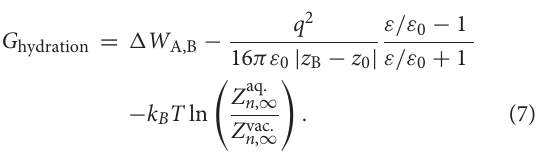
as a continuous medium. For this range, the attraction on